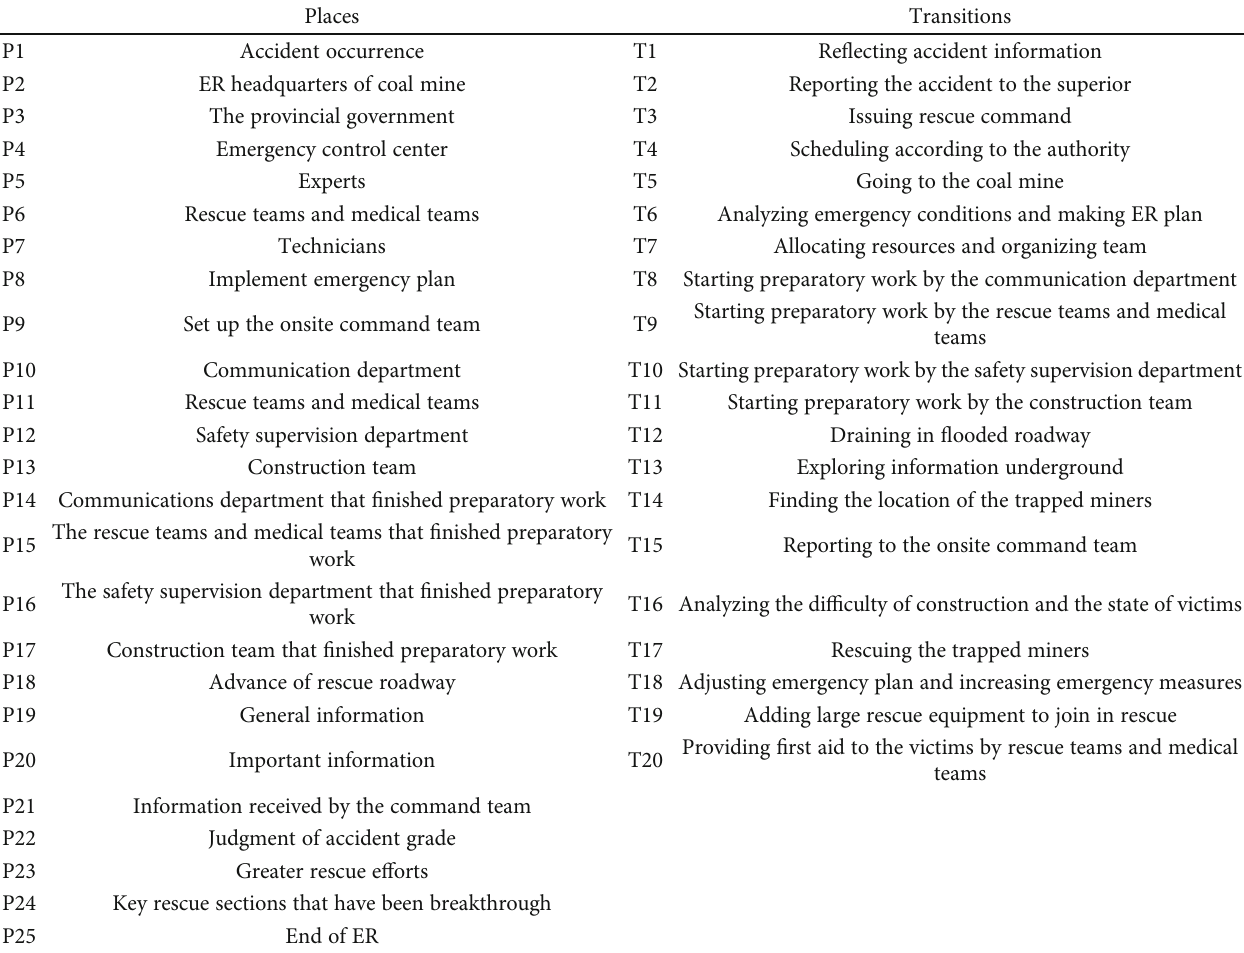
Table 1: De fi nitions of places and